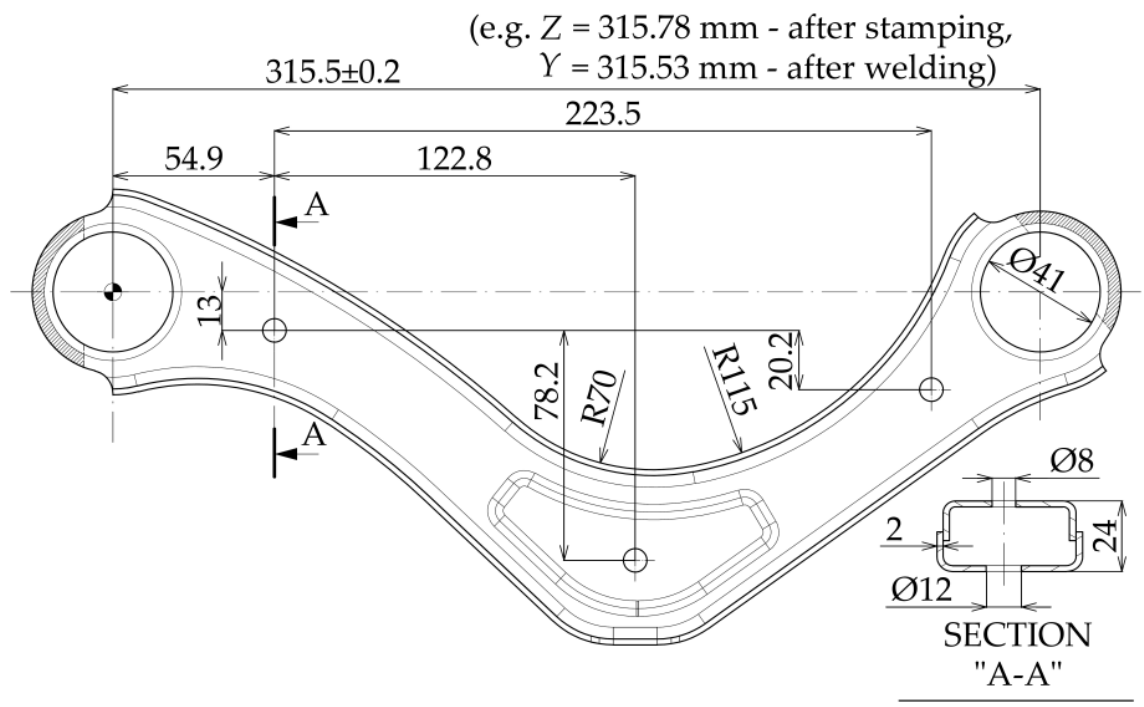
Figure 1. A research object and the dimension to be examined.